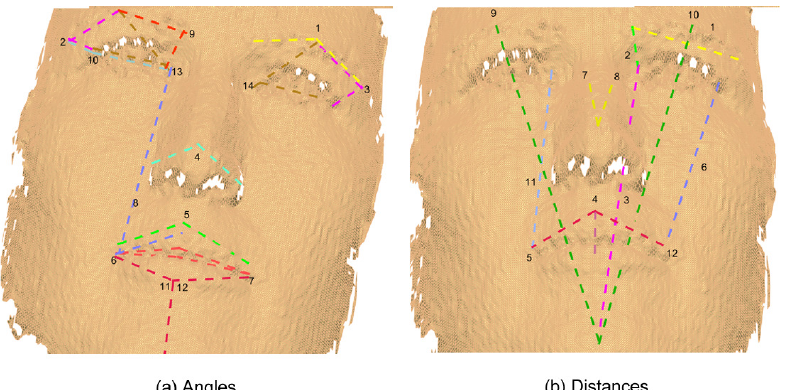
Figure 8. Original 3D features.